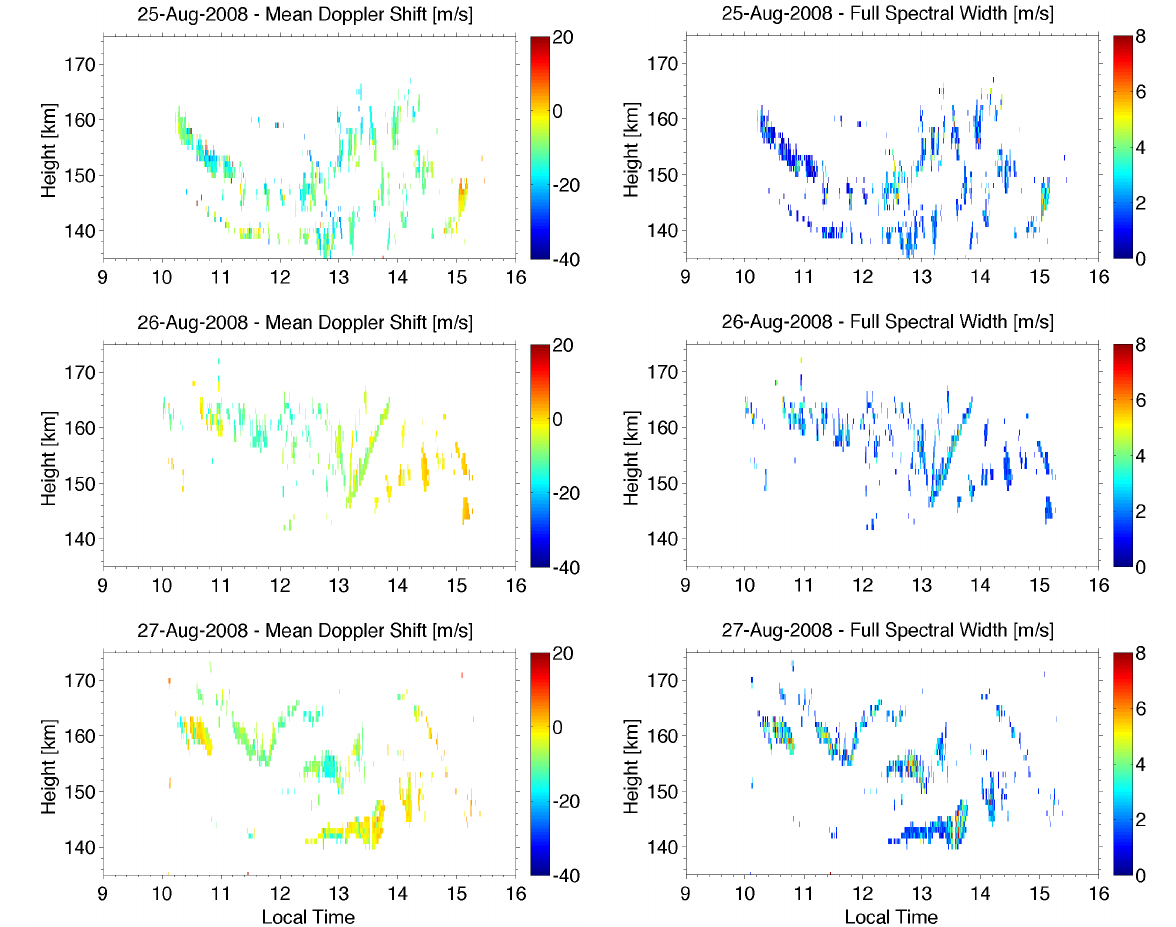
Fig. 4. Mean Doppler velocities (left-side panels) and full spectral widths (right-side panels) for SNR > − 5dB echoes observed on 25, 26 and 27 August